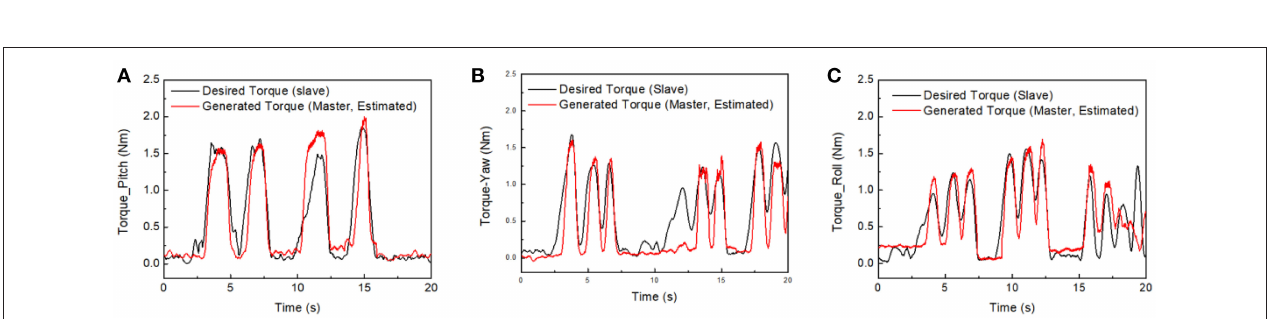
FIGURE 12 | Repulsive torque tracking control results. (A) Pitch motion. (B) Yaw motion. (C) Roll Motion.